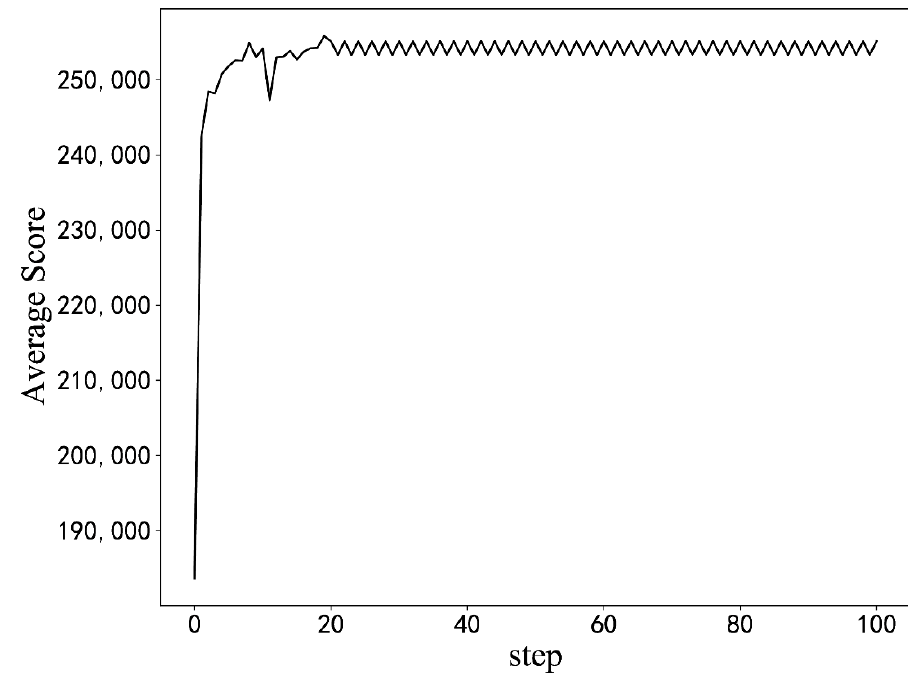
Figure 8. Optimization result from the initial configuration. (The results of simulation experiments). Table 3. List of hyperparameters and their values.